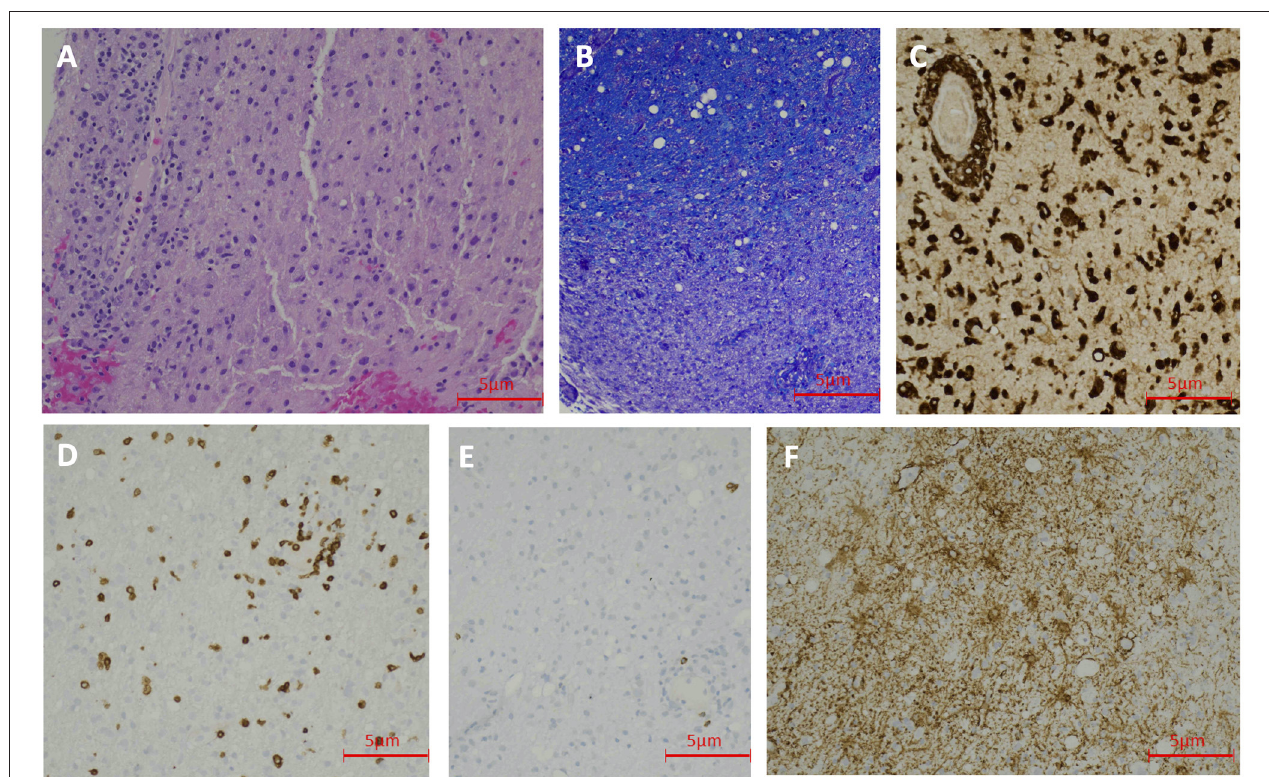
FIGURE 2 | Case 1 Pathology: Hematoxylin and Eosin staining shows lymphohistocytic infiltrate in the brain tissue (200 X) (A) . LFB staining demonstrates demyelination (200 X) (B) . CD68 immunohistochemical stain shows numerous histiocytes (200 X) (C) . CD3 immunohistochemical stain reveals scattered T-lymphocytes (200 X) (D) . CD20 immunohistochemical stain demonstrate rare B-lymphocytes (200 X) (E) . GFAP immunohistochemical stain shows reactive astrocytes (200 X) (F)